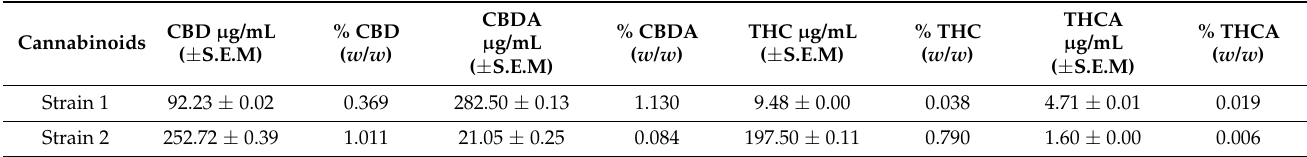
Table 5. Amount of cannabinoids in the SCF extract of two different cannabis strains. CBD µ g/mL Cannabinoids ( ±